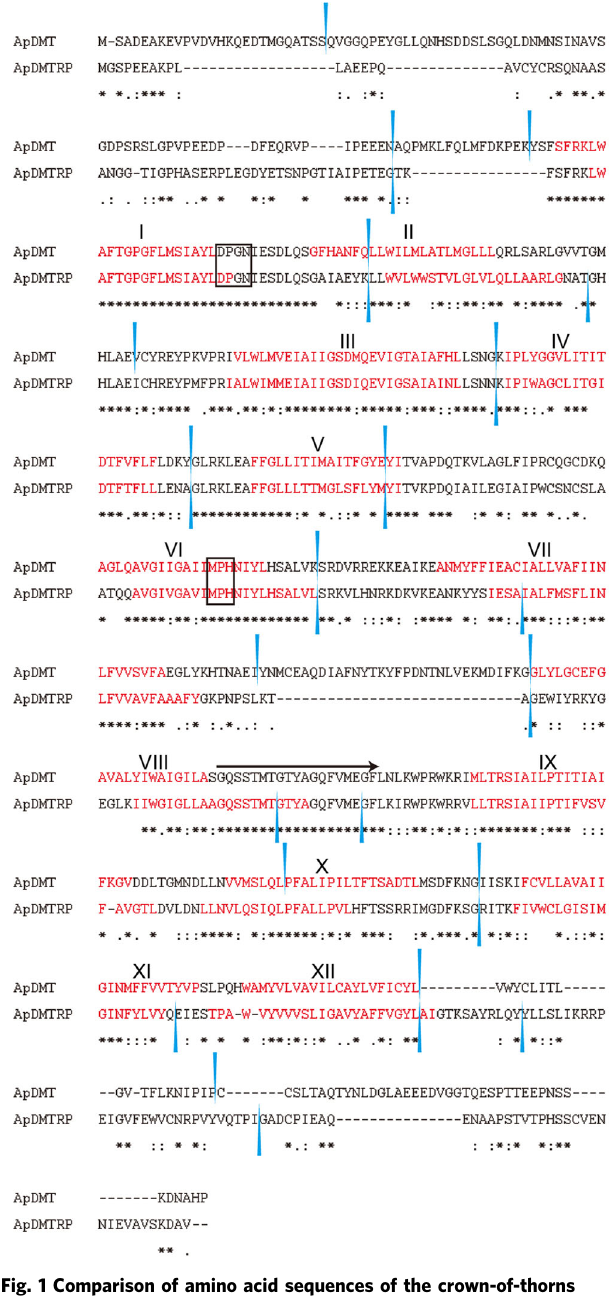
Fig. 1 Comparison of amino acid sequences of the crown-of-thorns star fi sh (COTS), Acanthaster planci , divalent metal transporter (ApDMT) and DMT-related protein (ApDMTRP). Alignment was carried out with MAFFT version 7. Identical amino acids are indicated by asterisks. Conservative and semi-conservative substitutions are indicated with colons and periods, respectively. Black arrows indicate consensus transport motifs (CTMs). Blue arrowheads indicate positions of introns. Black boxes indicate functionally important amino acid